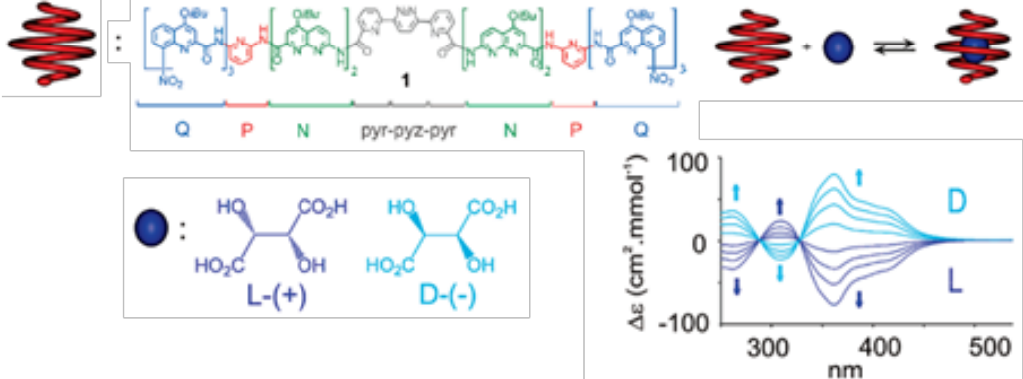
Figure 10. CD evidence of diastereoselective encapsulation of tartaric acid by a helical aromatic oligoamide [33].